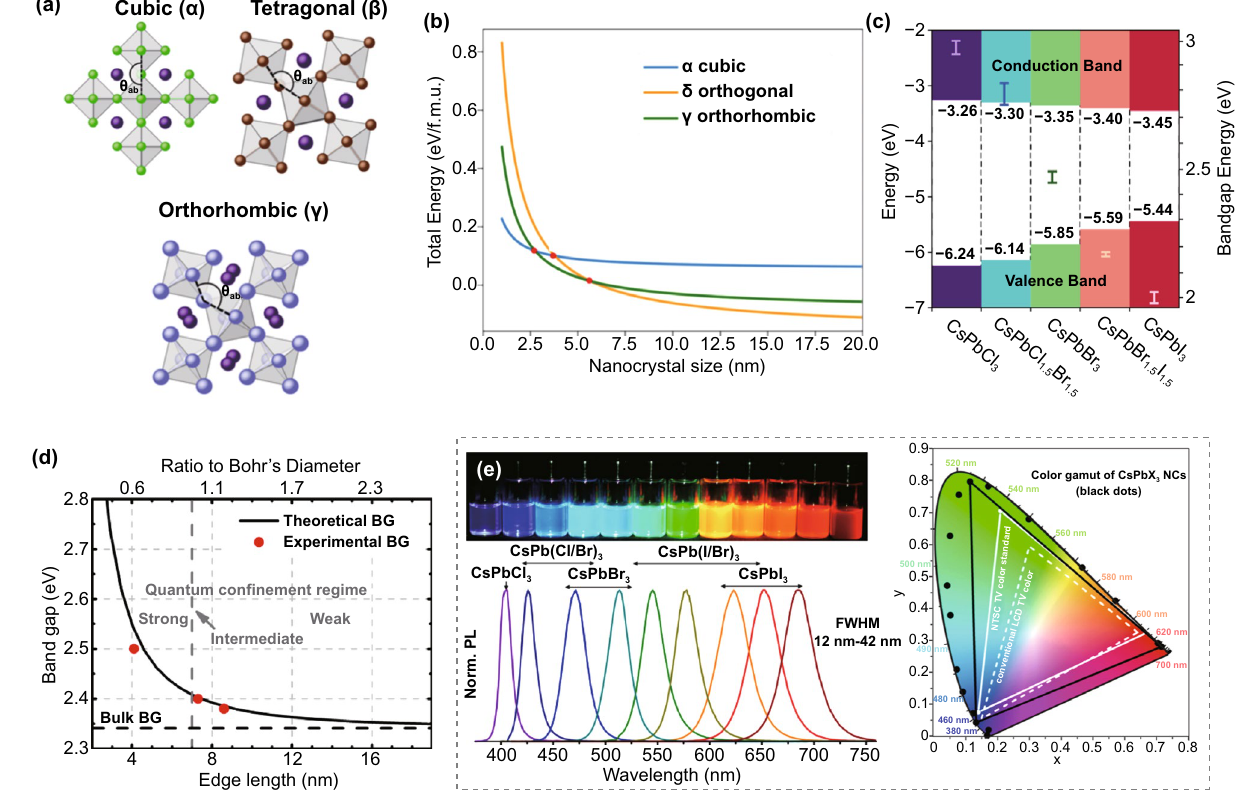
Fig. 1 a Polymorphic structures of CsPbX 3 . Adapted with permission from Ref. [60]. Copyright 2015, American Chemical Society. b Forma- tion energy of α, γ, and δ-phases of CsPbI 3 as a function of size. Adapted with permission from Ref. [67]. Copyright 2020, American Chemical Society. c Energy diagrams of representative inorganic perovskite QDs. d Experimental versus theoretical size-dependent bandgap energy of CsPbBr 3 QDs. Adapted with permission from Ref. [69]. Copyright 2017, American Chemical Society. e Photos of inorganic perovskite CsPbX 3 (X = Cl, Br, I) QD colloidal dispersions, along with PL emission spectra and corresponding CIE chromaticity coordinates. Adapted with